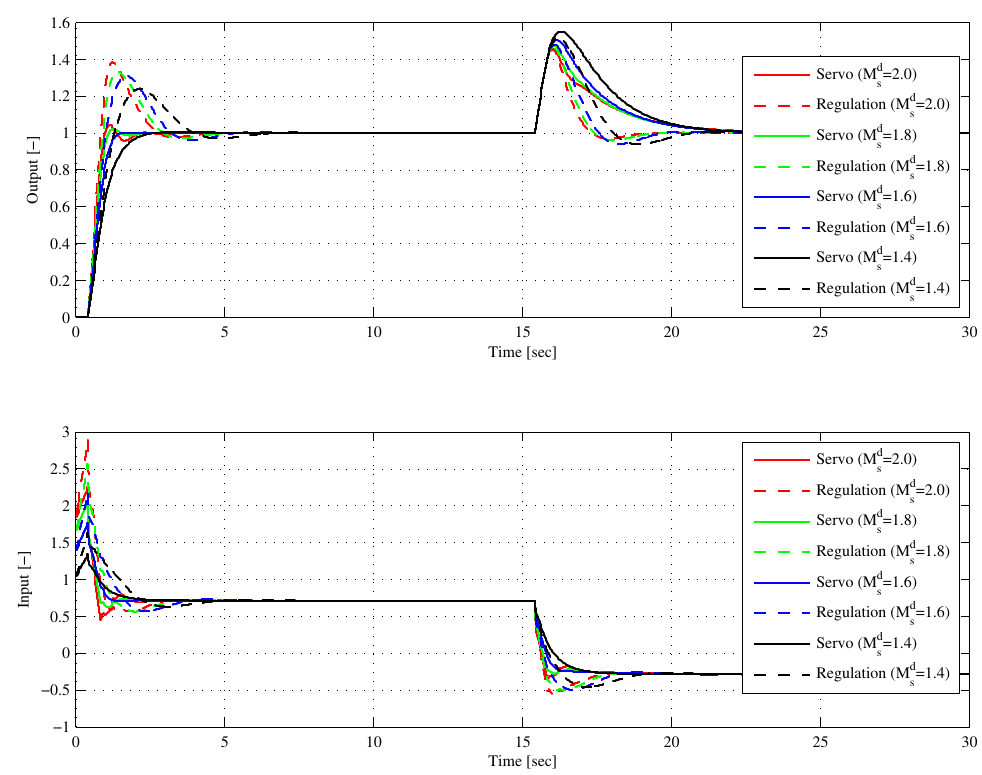
Figure 6. Output and input responses obtained using the proposed method in both servo and regulator design, where the system is disturbed by a unit step disturbance after 15 s.